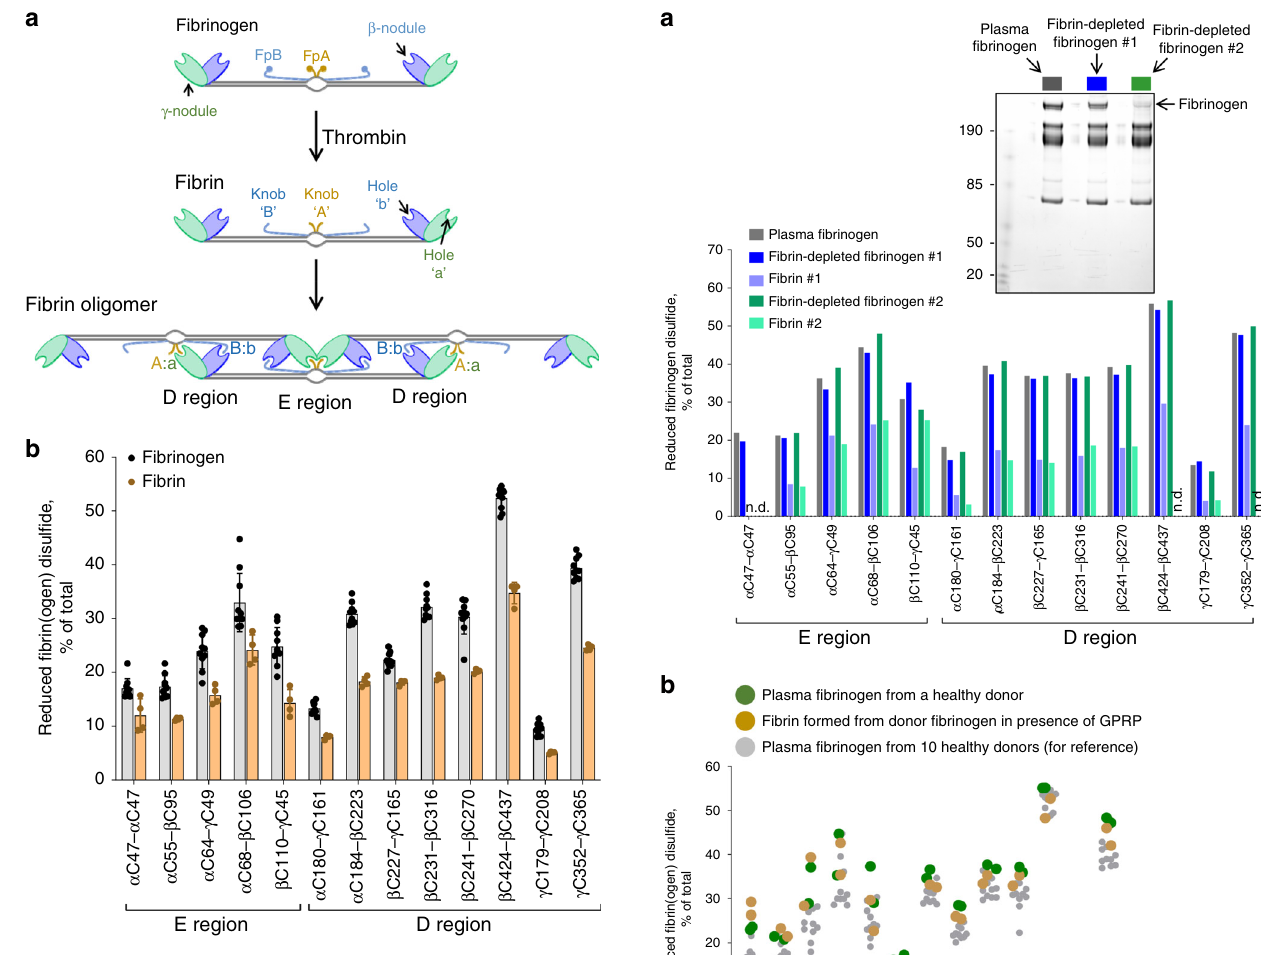
Fig. 2 The disul fi des in fi brin polymer are more oxidized than the bonds in fi brinogen. a Conversion of fi brinogen to fi brin is mediated by thrombin proteolysis of fi brinopeptides (Fp) A and B in the central E region to form knobs “ A ” and “ B ” . Fibrin oligomers are formed when the exposed knobs “ A ” and “ B ” bind to holes “ a ” and “ b ” in the γ - and β -nodules, respectively. b Redox states of the fi ve E region and eight D region disul fi des in fi brinogen (10 donors) and fi brin polymer (in 4 of the 10 donors). The bars and errors are mean ± SD. All 13 disul fi des are more oxidized in fi brin polymer: p < 0.05 for the α C68- β C106 bond and p < 0.01 for the other 12 bonds. Parametric unpaired t -test was used to evaluate differences between groups. Source data are provided as a Source Data fi le. form as a result of fi brin polymerization. We next investigated the polymer formation.